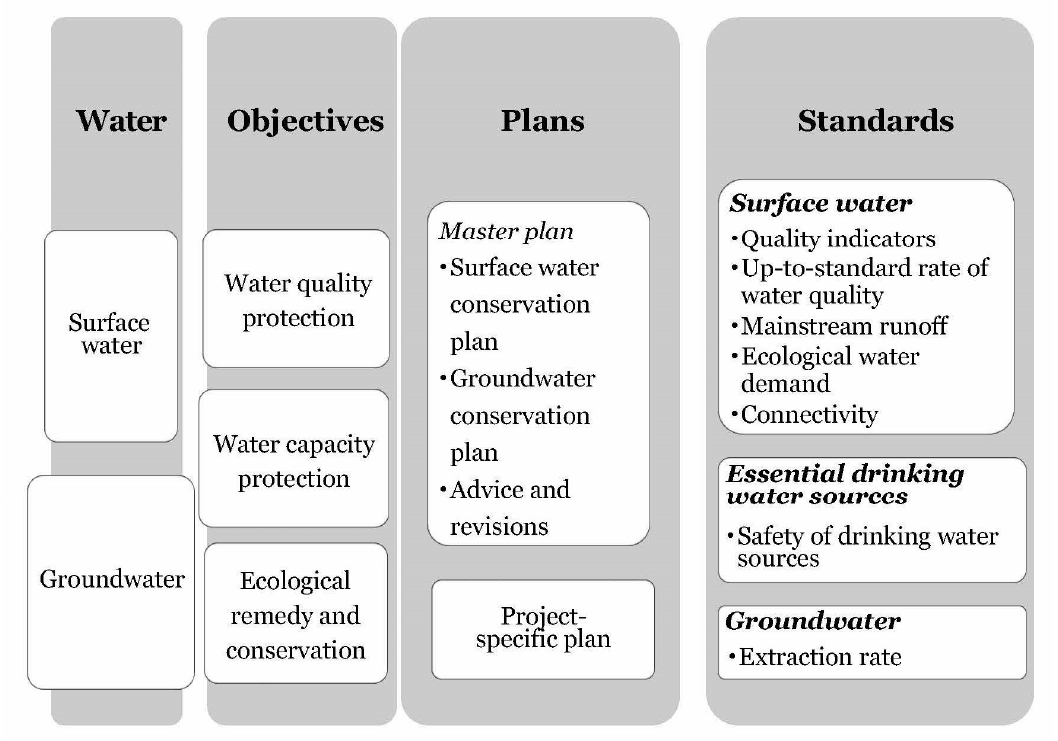
Figure 8. Water management system in China.